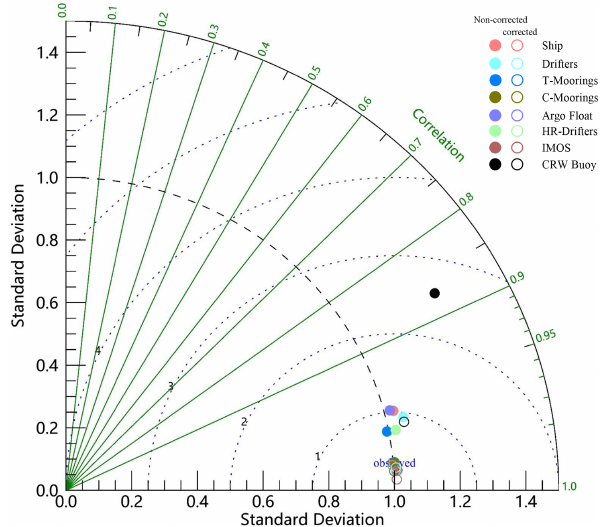
Figure 14. Normalized Taylor diagrams showing differences be- tween matched SST from in situ data before and after correction and the corresponding MODIS SST